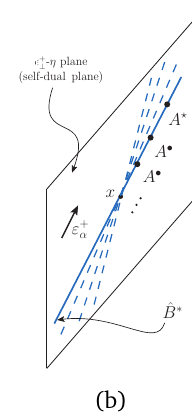
Figure 1: Left: The straight infinite Wilson line B • living on the self-dual plane = (cid:34) + − αη and integrated over all α (the dashed, tilted Wilson lines spanned by (cid:34) + α ⊥ represent the change of α ). Right: The B (cid:63) field can bee seen as the straight infinite Wilson line similar to the one on the left, but here one A • field has been substituted by the A (cid:63) field in the expansion (with a suitable symmetry factor). (Source of the figure: Ref. [ 7 ]